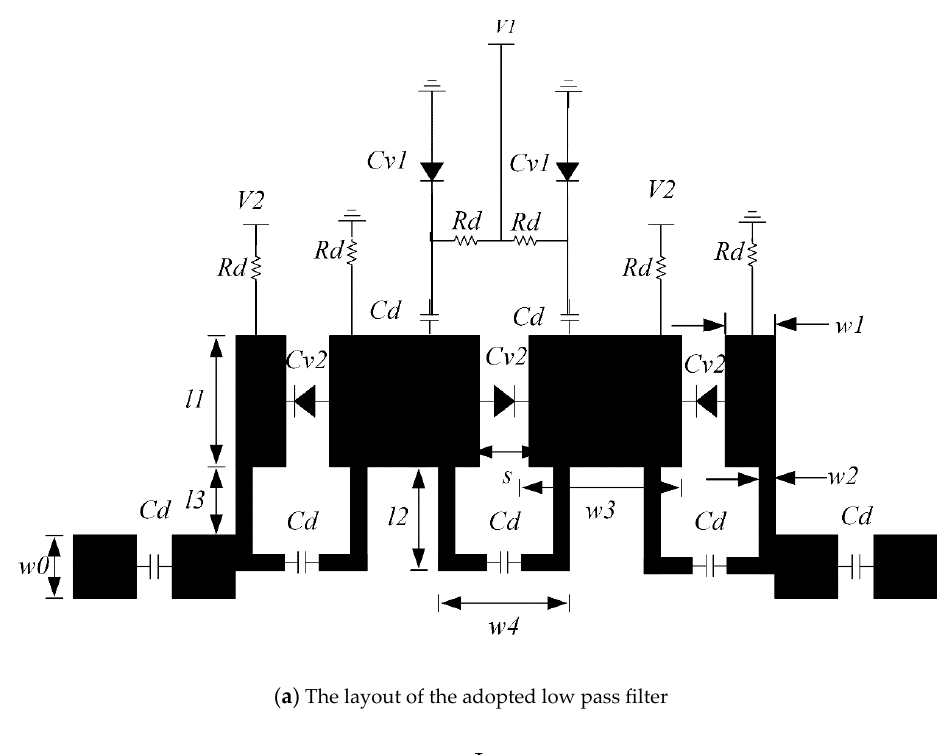
Table 3. Tunable capacitance for different operating modes .